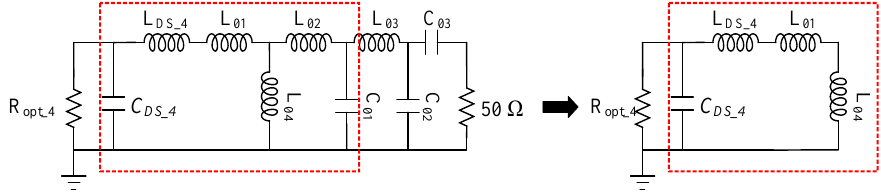
Figure 6. The simplified output second-harmonic tuned network when L 04 is analyzed.